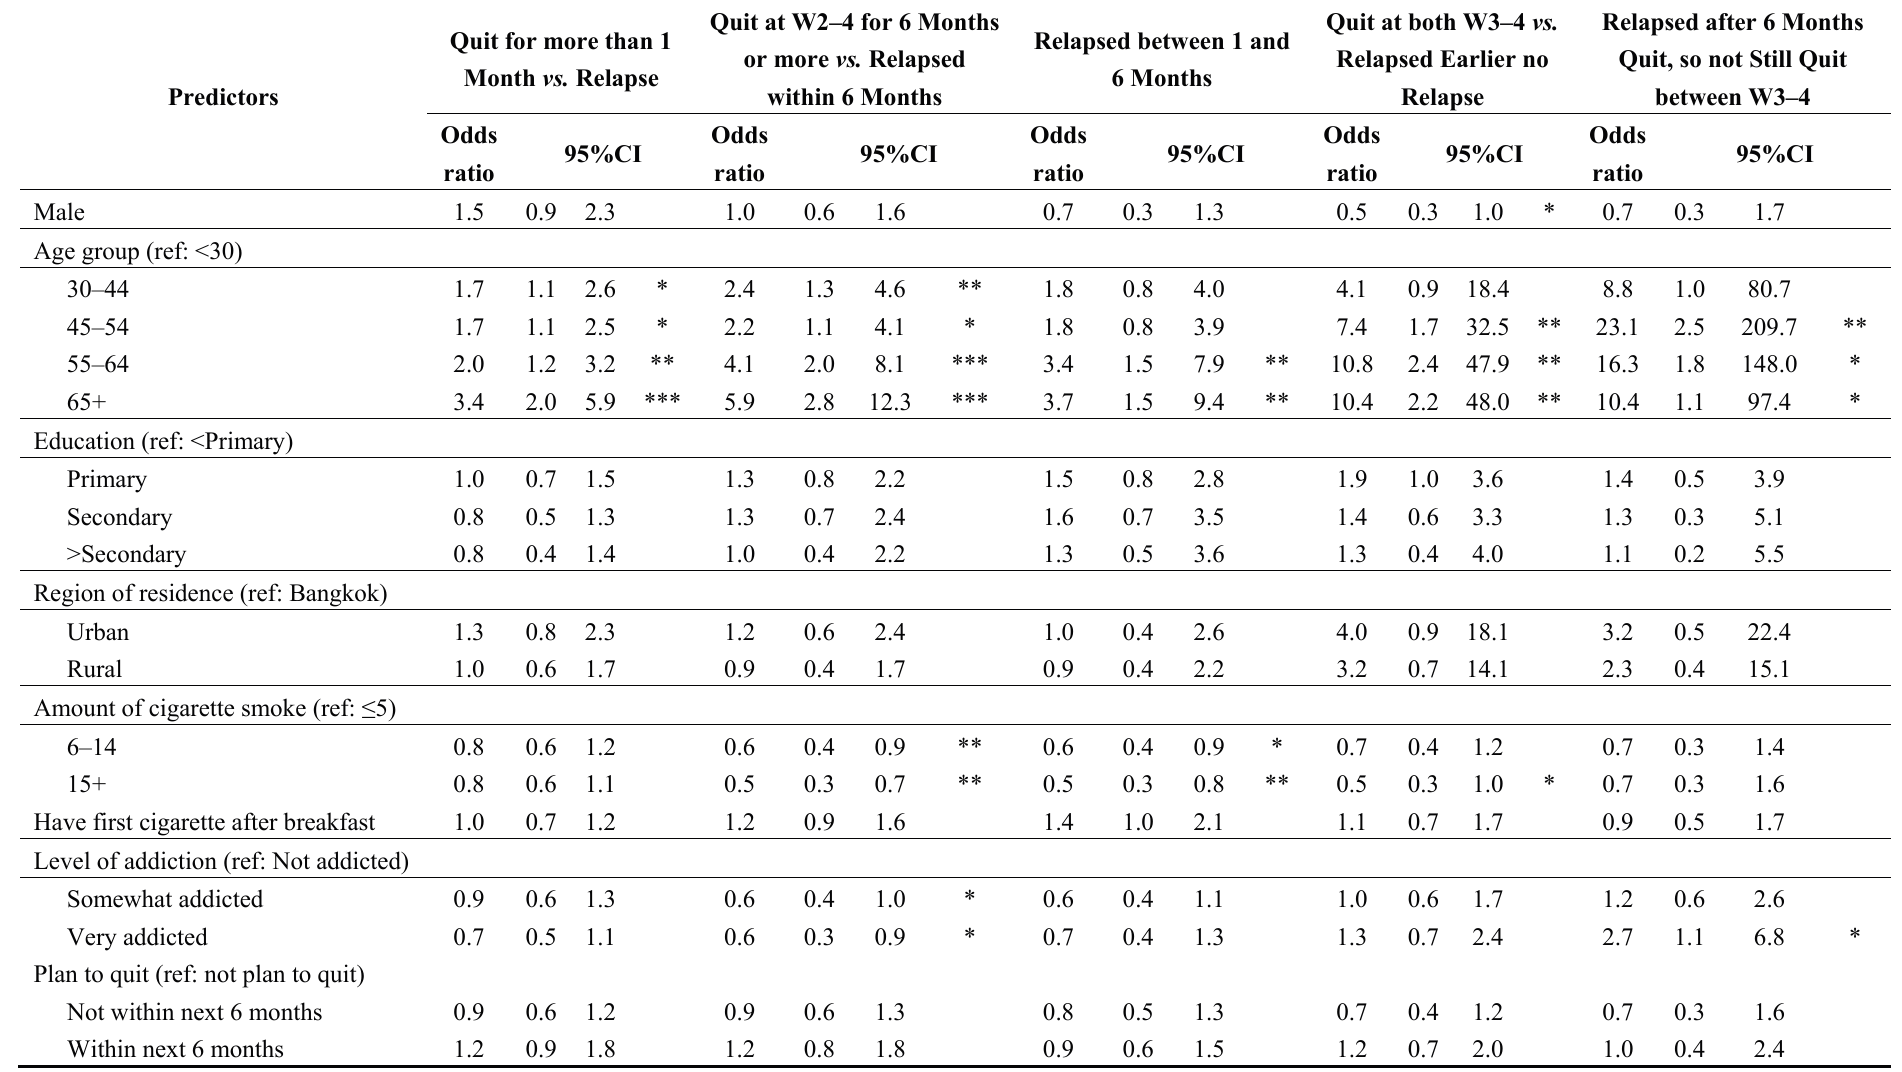
Table 3. Predictors of successful quitting behaviors for each outcome